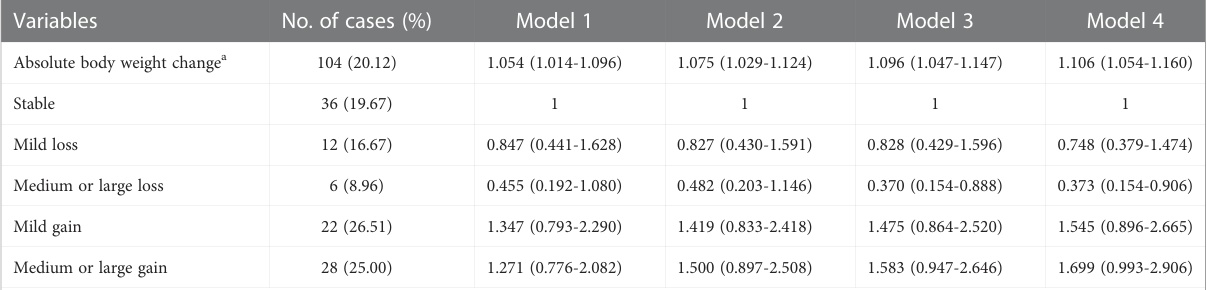
TABLE 4 Associations between absolute body weight change and risk of metabolic abnormalities in subjects with overweight/obesity. Variables